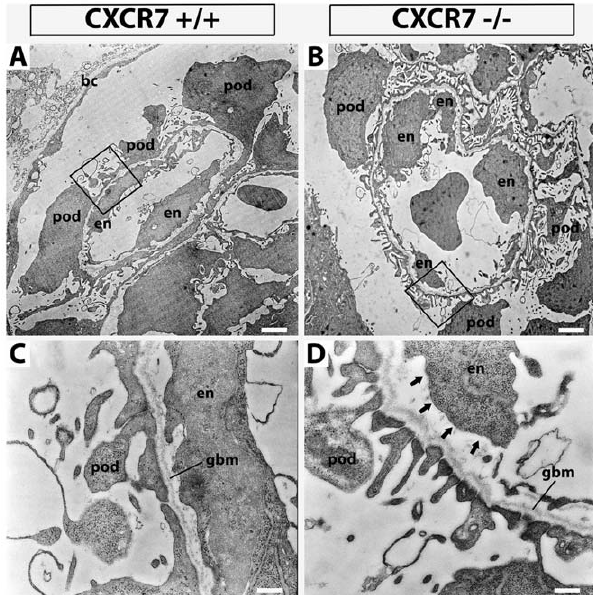
Figure 7. Transmission electron microscopic analysis of the glomeruli. Glomerular capillaries at 3.300 6 magnification ( A , B ) and details of the filtration barrier at 21.600 6 magnification ( C , D ; framing in A,B). CXCR7 + / + (C) and CXCR7 2 / 2 (D) showed no differences in general morphology and glomerular basement membrane (gbm) attachment of podocytes (pod). However endothelial cells (en) seemed to be detached from the gbm (arrows). Scale bars correspond to 2 m m (A,B) and 0.3 m m